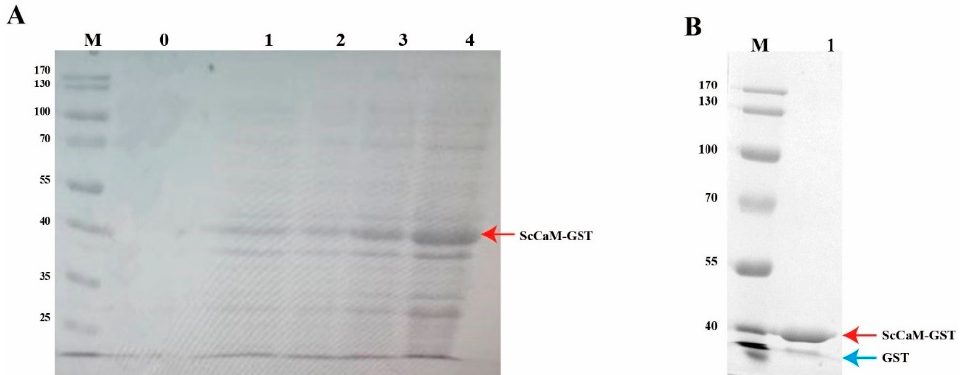
Figure 3. Prokaryotic expression of the pGEX-4T- ScCaM fusion protein in Escherichia coli BL21 (DE3). ( A ). Prokaryotic expression of the pGEX-4T- ScCaM fusion protein in Escherichia coli BL21 (DE3) by 0.5 mM of IPTG induced at 16 °C. Note: M, protein marker; 0, control; 1–4, pGEX-4T- ScCaM induction for 0, 2, 8, and 20 h, respectively. ( B ). Prokaryotic expression of the pGEX-4T- ScCaM fusion protein in Escherichia coli BL21 (DE3) after 0.5 mM of IPTG induced for 20 h at 16 °C. Note: M, protein marker; 1, pGEX-4T- ScCaM induction for 20 h.